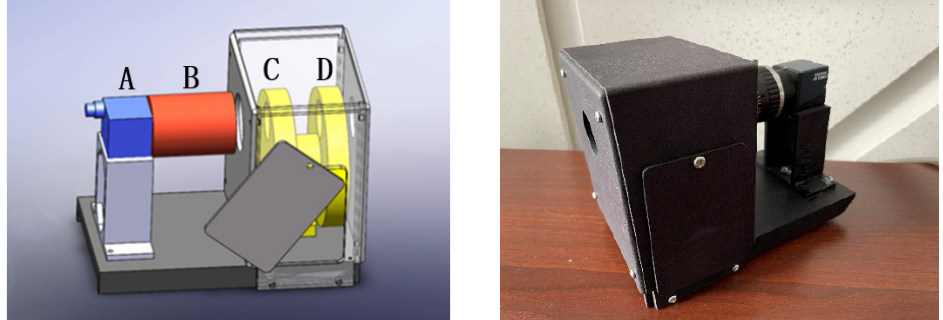
Figure 1. Super-resolution image reconstruction. ( Left ): remote sensor model diagram (A, camera; B, optical lens; C, filter; D, polarizer). ( Right ): physical remote sensor prototype.